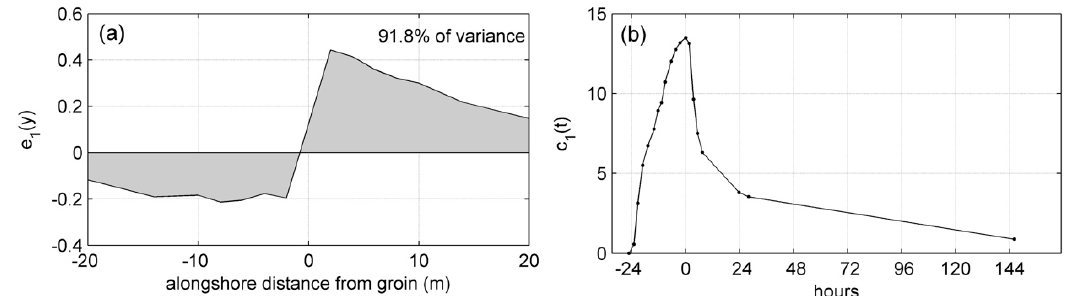
Figure 10. Empirical orthogonal function analysis of the shoreline data during the experiment (27 May–3 June, 2015). Only the ( a ) spatial function and ( b ) the temporal evolution of the first mode are shown.